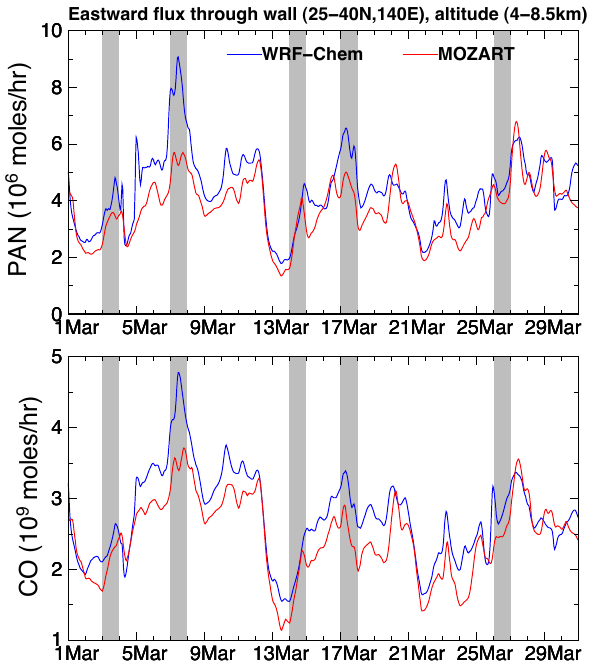
Figure 3. Comparison of MOZART and WRF-Chem calculated zonal fluxes of CO and PAN along 140 ◦ Ethat isintegrated over 4-8.5 kmaltitudes and 25 ◦ -40 ◦ N latitudes. The shadedbandsindicate Fig. 3. Comparison of MOZART and WRF-Chem calculated zonal the timing of cold frontal passages over central China in March 2001. fluxes of CO and PAN along 140 ◦ E that is integrated over 4-8.5km altitudes and 25 ◦ –40 ◦ N latitudes. The shaded bands indicate the timing of cold frontal passages over central China in March 2001.